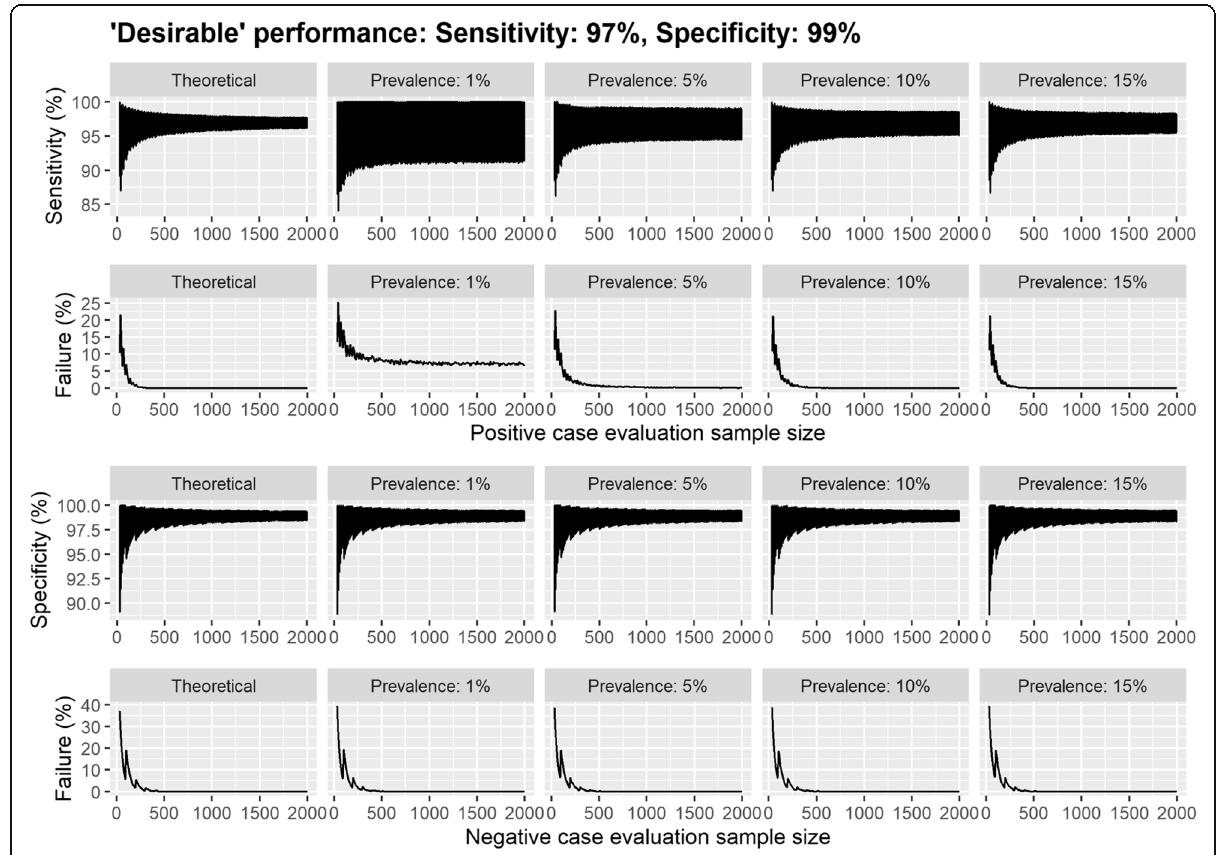
Fig. 2 D min scenario estimates of diagnostic performance from a series of Monte Carlo simulations per evaluation sample size. Each simulation consisted of 10,000 iterations each consisting of 5,000 individuals. Here the diagnostic test was assumed to be greater than or equal to the performance for the desirable MHRA TPP with 97% sensitivity and 99% specificity in the evaluation sample. The 95% confidence intervals are displayed for sensitivity and specificity per initial evaluation sample size across different prevalence scenarios. The simulation was considered to have met the TPP confidence interval criterion if the diagnostic characteristic was above the lower bound of the 95% CI specified in the TPP (93% sensitivity and 97%